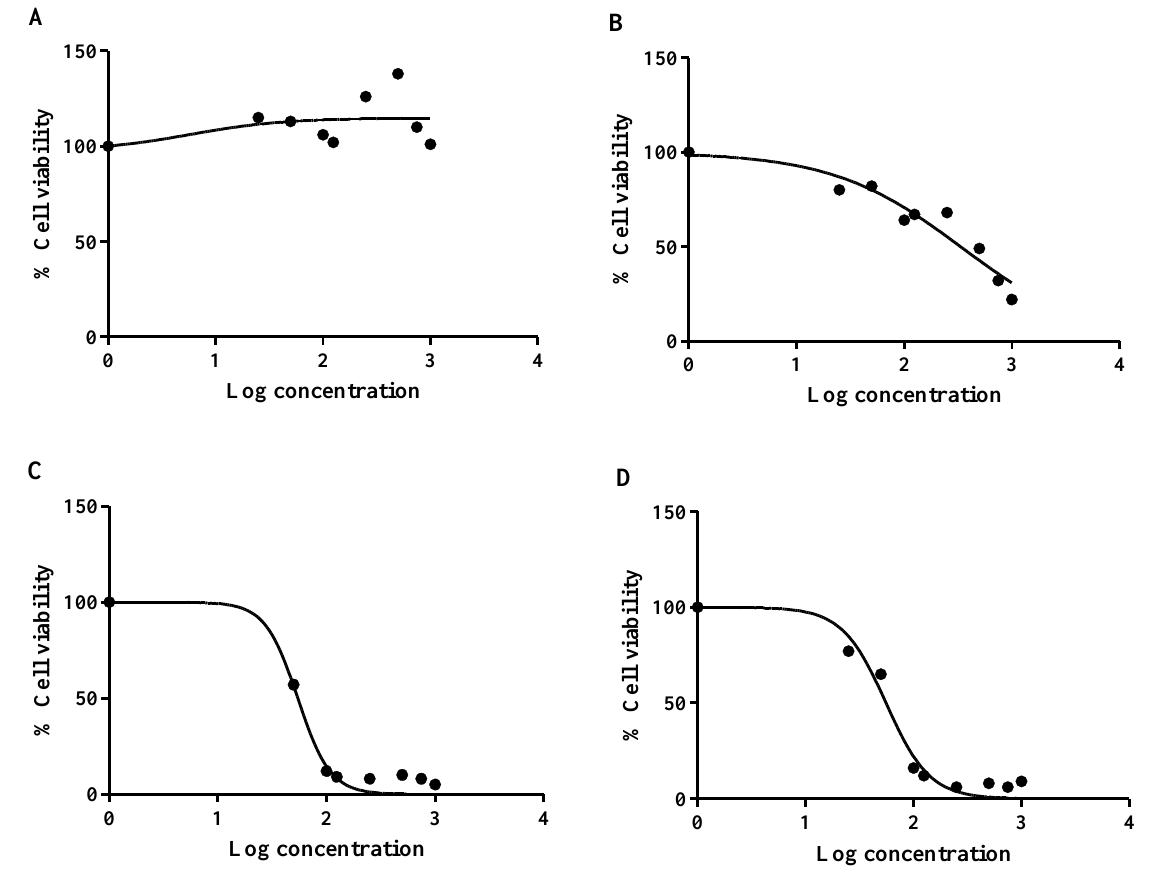
Figure 5. The dose response curves derived from the MTT assay. ( A ) The mushroom extract was not cytotoxic to HepG2, with increased cell viability occurring with increased concentrations. ( B ) Cell viability decreased gradually in Hek293 cells treated with increasing mushroom extract concentra- tion. ( C ) ZnO mushroom nanoparticles decreased cell viability significantly between 10 and 100 µg/mL in HepG2 cells, with more than 80% cell death from 1000 to 2000 µg/mL. ( D ) The Hek293 cell response to ZnO mushroom nanoparticles indicates cytotoxicity at all concentrations. Table 2. The extrapolated IC25 and IC50 concentrations for HepG2 and Hek293 cells.